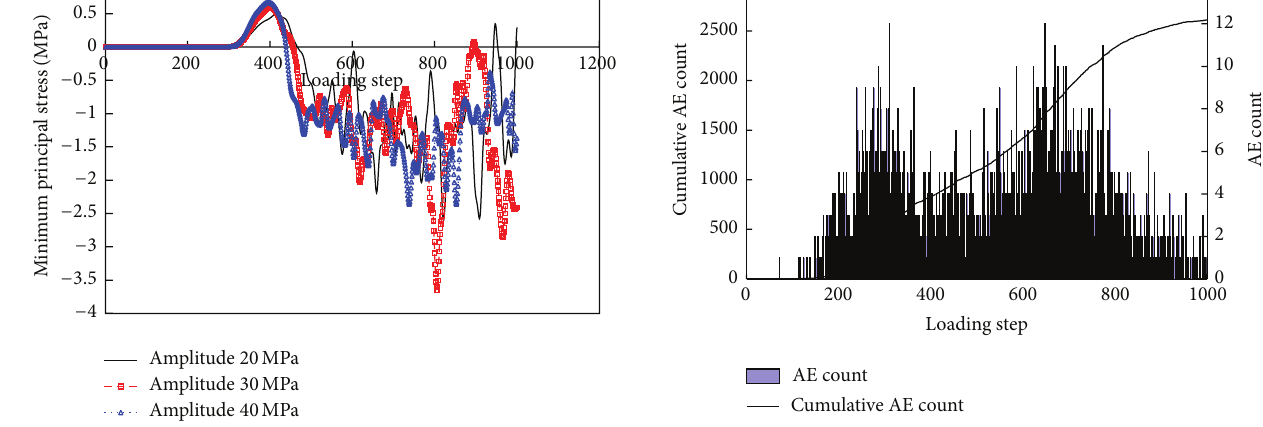
Figure 6: Variation law of minimum principle stress on numerical sample unit.